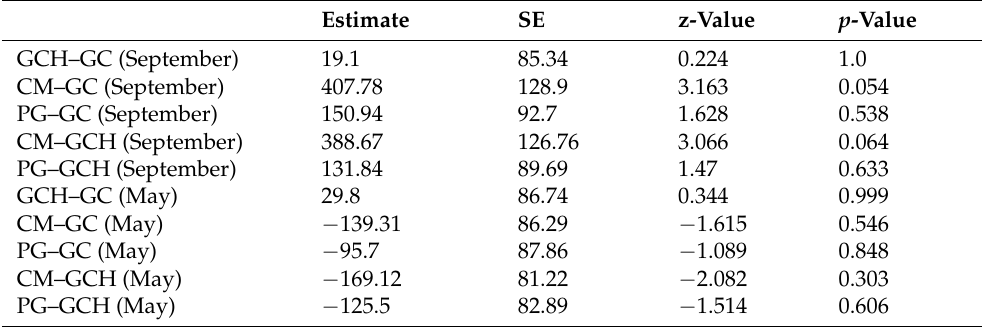
Table A14. Differences in the biomasses of carabid beetles, comparing grass–clover (GC) and grass– clover herbs (GCH) with each other, and in comparison to conventional maize (CM) and permanent grasslands (PG) in May/June and